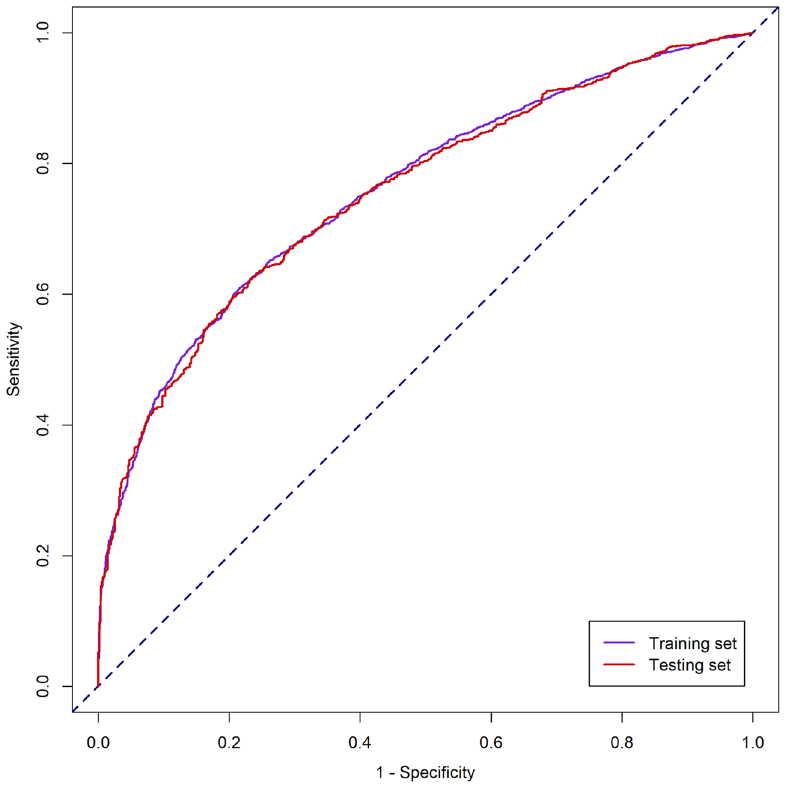
Figure 4. Receiver operating characteristic curve of the simplified risk prediction model in the training and testing set.